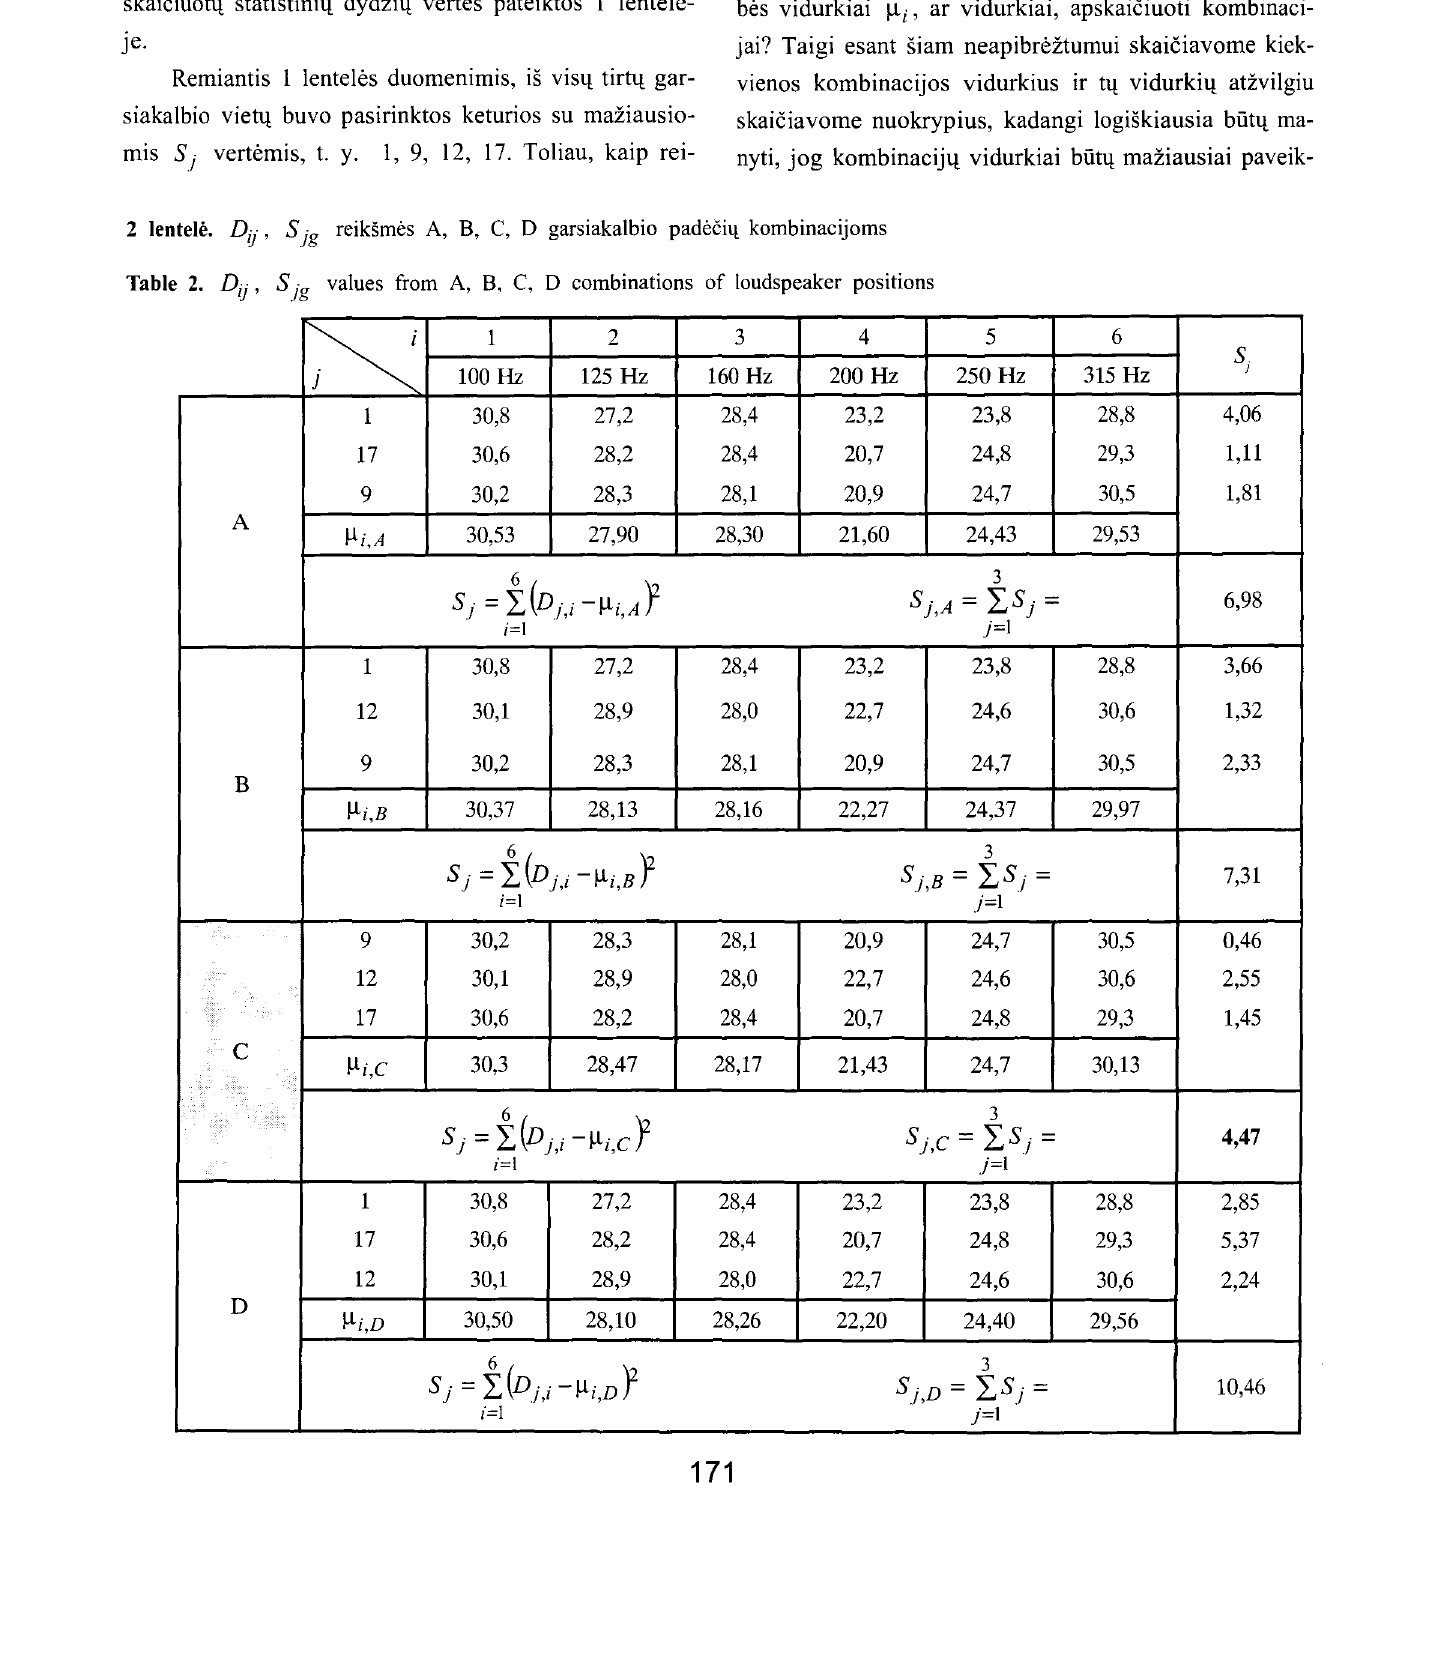
Table 2. Dij , S jg values from A, B, C, D combinations of loudspeaker